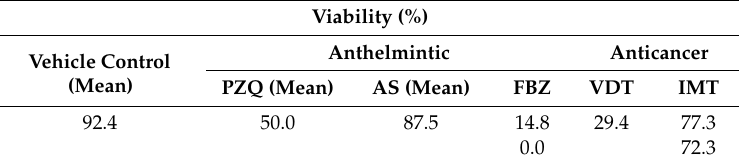
Table 3. Viability of NTS of S. mansoni (percentage) at 72 h of exposure to anthelmintic drugs (PZQ, AS, and flubendazole (FBZ)) and anticancer drugs (vandetanib (VDT) and imatinib (IMT)) at 100 µ M in vitro.